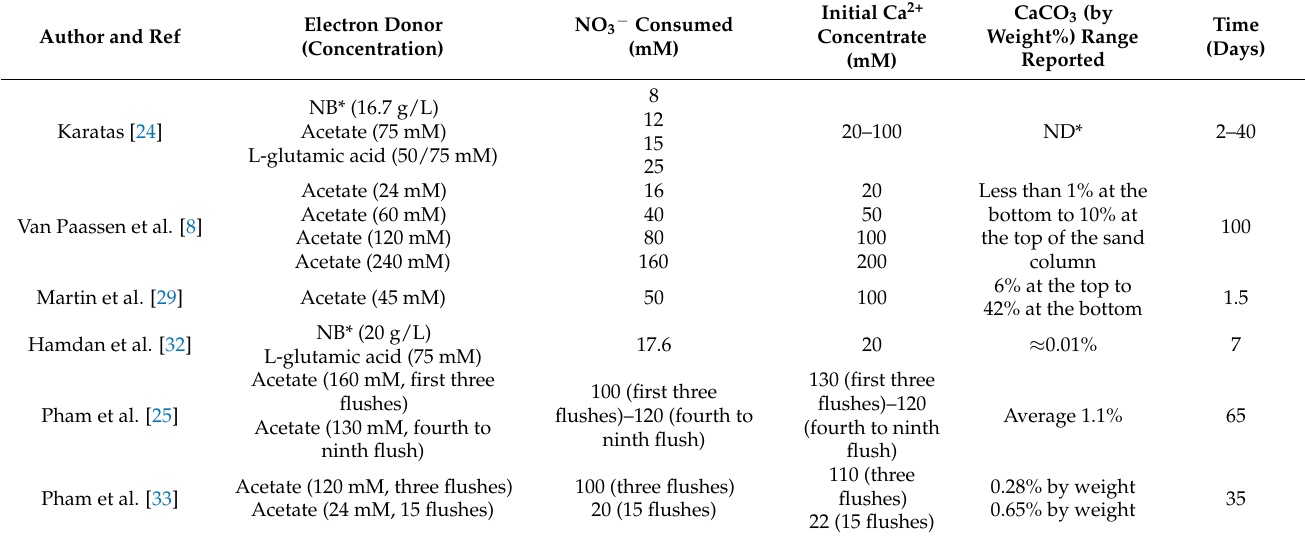
Table 3. Overview of key findings reported in the literature for soil improvement by denitrification-based